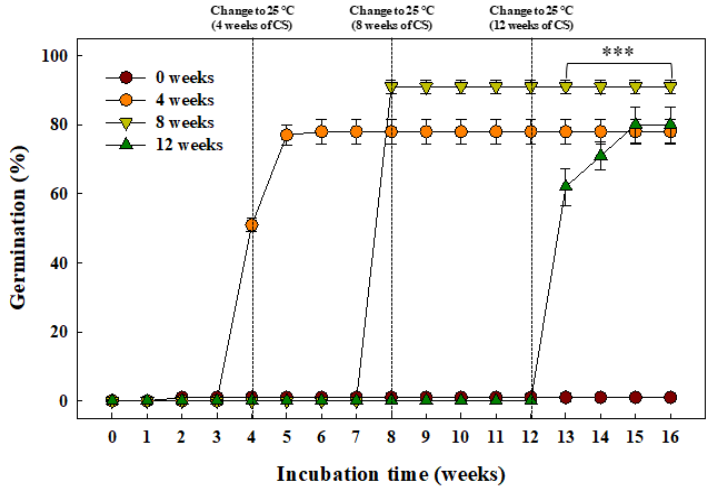
Figure 5. Cumulative germination of the Gentiana triflora var. japonica (Kusn.) H. Hara seeds treated with cold stratification (0, 4, 8, or 12 weeks). Vertical bars represent the standard deviation from the mean ( n = 4). *** Significant at p ≤ 0.001.